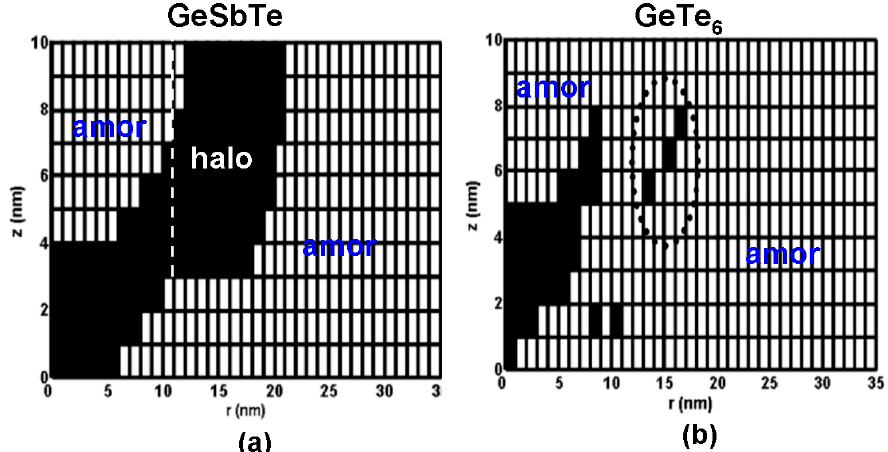
Figure 19. Erasing (re-amorphizing) of the crystalline bits for ( a ) conventional GST (using a 5 V, 200 ns pulse) and ( b ) a notional slow-growth material (using a 4.5 V, 200 ns pulse). Pulse rise/fall time was 20 ns in both cases. The suppression of the crystal ‘halo’ in ( b ) is clear although residues of it persist (circled). Reproduced with permission from [47]. Copyright Ieee Xplore, 2011.